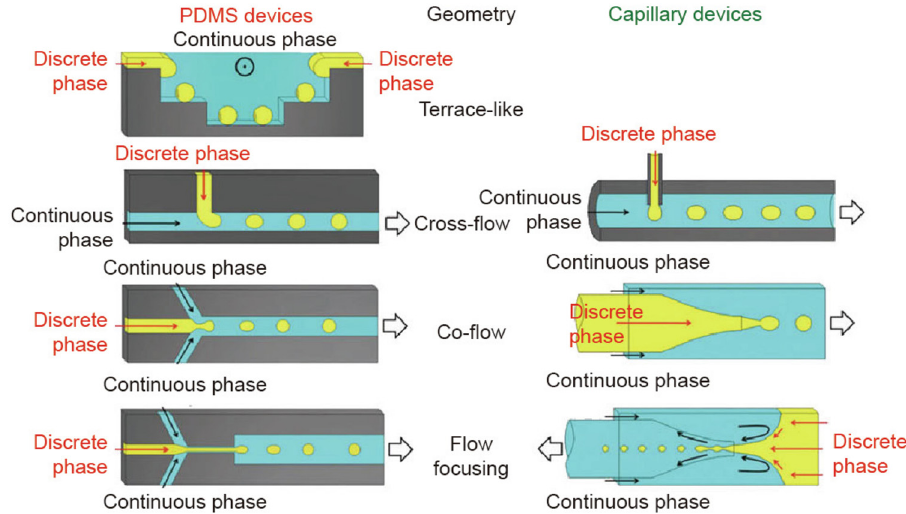
Figure 4: Di ff erent method of creating micro - /nano - capsules by micro fl uidic devices [ 64 ] : left 2D PDMS devices and right 3D glass capillary.